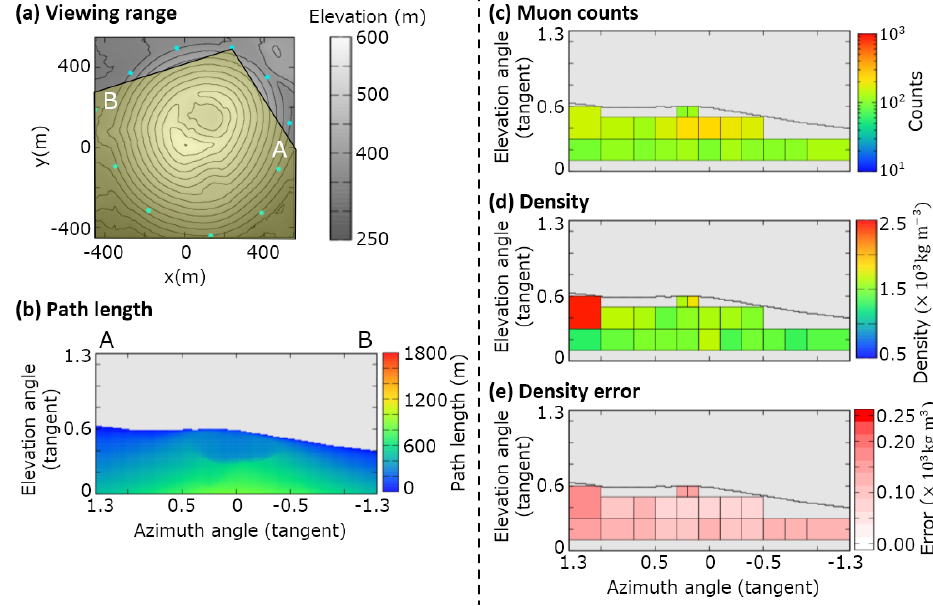
Figure B10. Observation site NNE. (a) Map, topography, and viewing range; (b) path length of the volcanic cone; (c) muon counts N obs (d) density ρ i . The maximum value of the color bar indicates a density of > 2 . 5 × 10 3 kgm − 3 and the minimum value is < 0 . 5 × 10 3 kgm − 3 . (cid:16) (cid:17) − ρ low ρ up / 2. The maximum value of the color bar indicates a density error of > 0 . 25 × 10 3 kgm − 3 (e) Density error (cid:49)ρ = i i